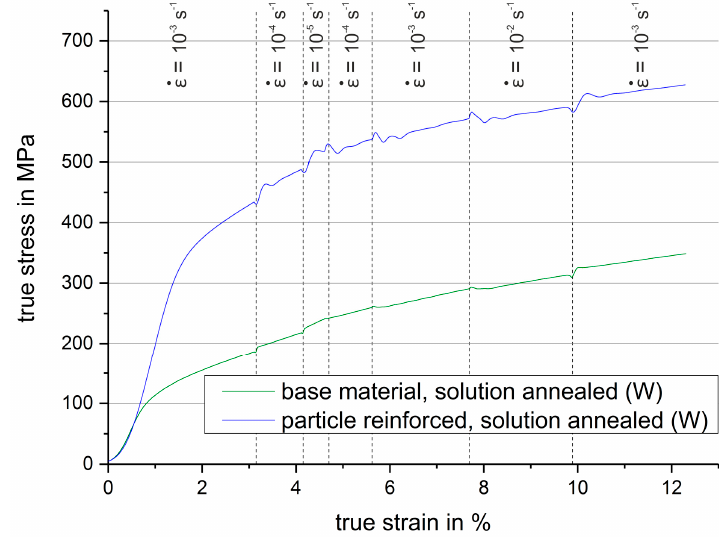
Figure 4. True stress-true strain curves measured in compressive jump tests with strain rates ranging from 10 − 5 s − 1 to 10 − 2 s − 1 for both materials in the solution annealed condition (W). When strain rates are reduced (first jumps and final jump), flow stresses are increased; an increase of the strain rate (intermediate jumps) leads to decreasing flow stresses. This clearly indicates that both materials exhibit a negative strain rate sensitivity. Table 2. Strain rate sensitivity m , determined from different strain rate jumps for solution annealed AA 2017 (base material and particle reinforced alloy). All data represent are arithmetically averaged parameters (±standard deviations) from at least three similar tests.